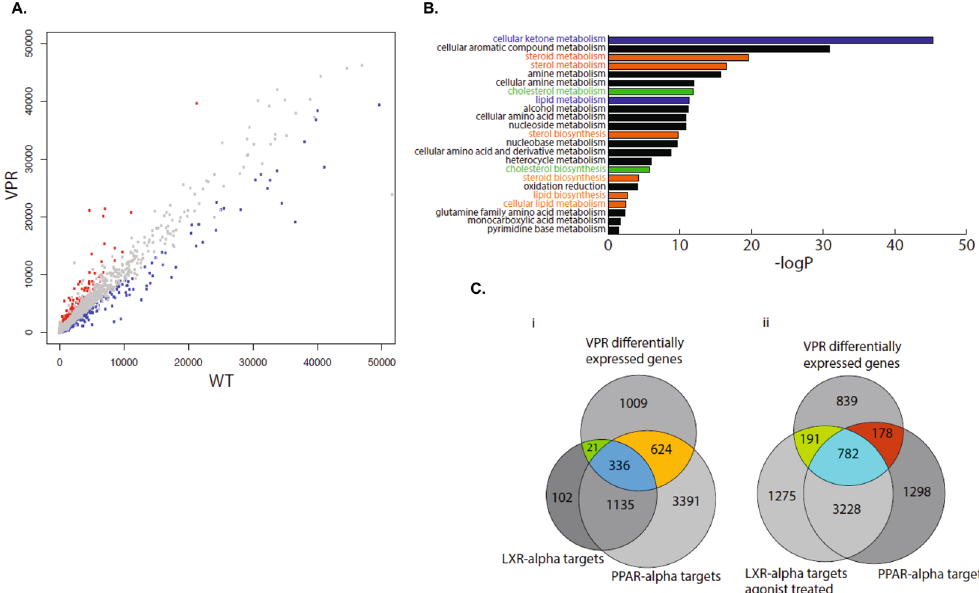
Figure 7. RNA-Seq analysis of liver reveals that Vpr regulates expression of a broad array of genes related to lipid metabolism. ( A ) Scatterplot of gene expression from RNA-Seq in Vpr-Tg compared with WT mouse liver. Each point represents a gene that was found to be expressed in both samples. The x-axis represents WT mouse expression and y-axis Vpr-Tg mouse expression in terms of library normalized counts. The red points are significantly upregulated genes and blue points significantly downregulated genes (P < 0.05). The plot is censored to a count of 50,000 for visualization purposes. ( B ) Gene ontology (GO) analysis for significantly different genes under the biological processes ontology framework. Of the genes for which expression differed significantly between Vpr-Tg and WT mouse livers, 46% belong to the ontology of metabolic processes. Significant ontologies within this subset are displayed (P < 0.05 using Benjamini correction, with a minimal fold change of 2). In particular, lipid and sterol metabolic pathways are highly represented. ( C ) Vpr binds preferentially to LXR α gene targets. LXR α and PPAR α targets were identified by filtering a genome-wide